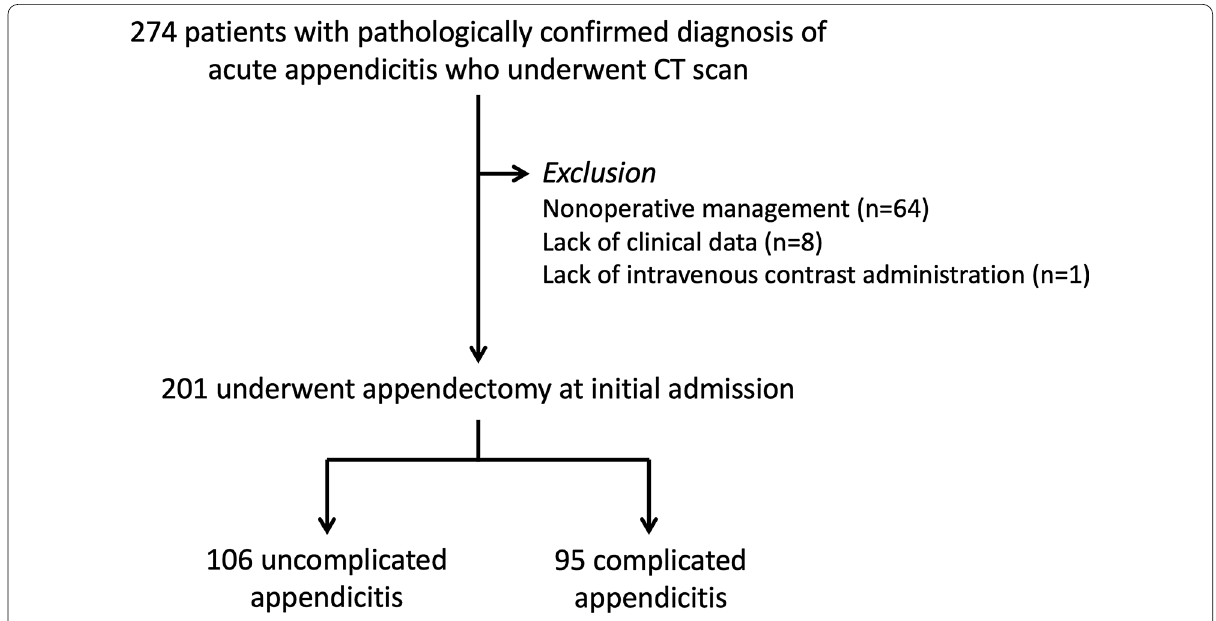
Fig. 1 Flowchart of selection of study patients